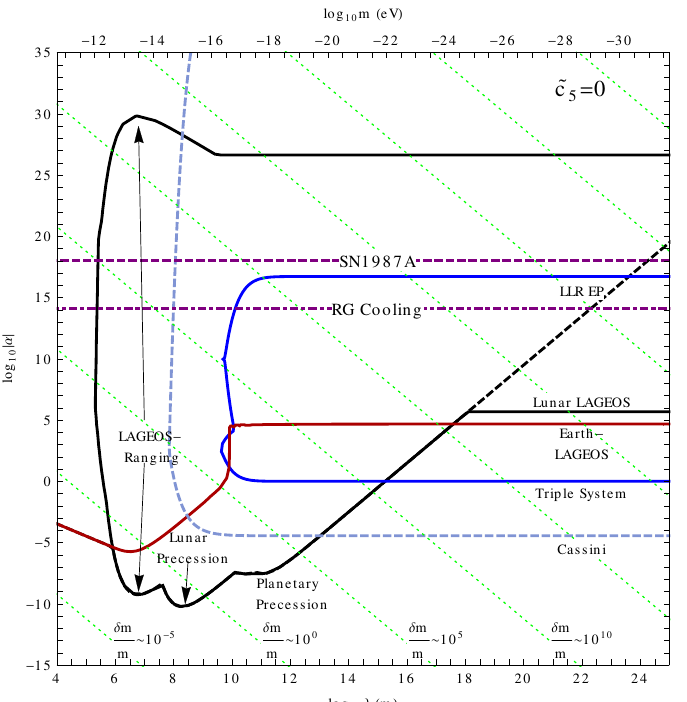
Figure 5 . Constraints on (cid:12)fth forces in the presence of natural quintic self-interactions from searches for EP-preserving forces excluding Earth-LAGEOS (black) and EP-violating forces (blue). The red contour indicates the constraint from Earth-LAGEOS [1], which is unbounded above as explained in the text, thereby closing all gaps in other experiments. Searches for EP-preserving forces shown include measurements made using the LAGEOS satellite [1, 33, 34], and the anomalous precession of the moon, Mercury and Mars [1, 35, 36]. The dashed black line shows the bounds in the absence of screening, while the solid contour shows the bounds with screening. The search for light de(cid:13)ection by the Cassini mission [17] is shown by a dashed light blue line. Searches for EP-violating forces shown include Lunar Laser Ranging (LLR-EP) [38] and the stellar triple system PSR J0337 (cid:0) 1715 [37]. These would not be present in the absence of screening. The purple dashed and dot-dashed lines indicate constraints from the cooling of SN1987A and Red Giants respectively [39{41]. The dotted green contours indicate the level of tuning of the mass required as a function of (cid:11)